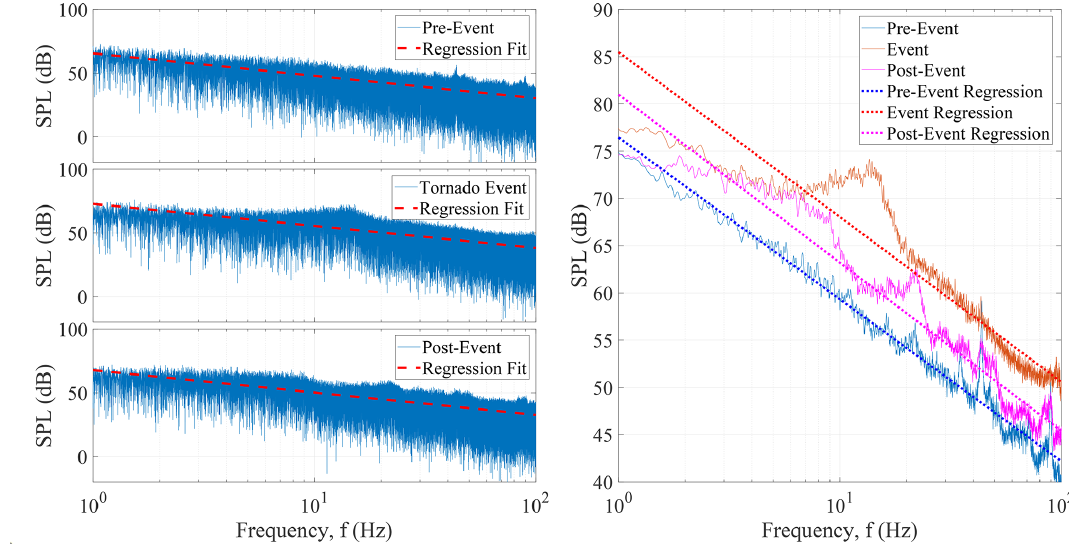
Figure 12. Frequency-domain GLINDA data during the Lakin, KS, tornadic event that occurred from 00:11 to 00:24UTC on 22 May 2020.